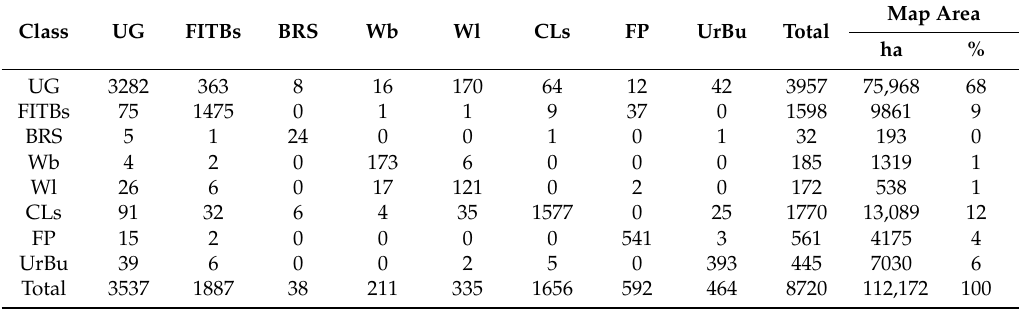
Table 6. Summarized accuracy assessment of LC map DLC 2014 (T2), based on sample counts.